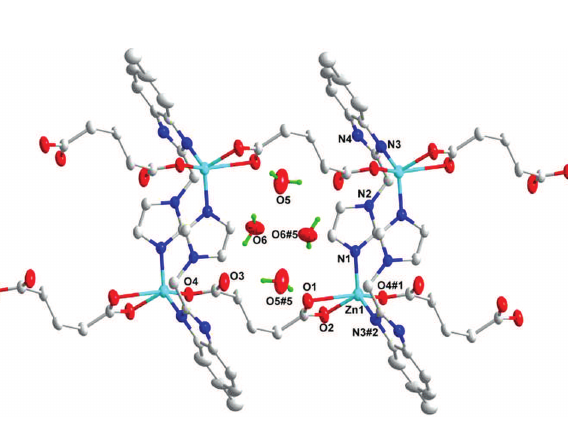
Figure 1: The structure of the title